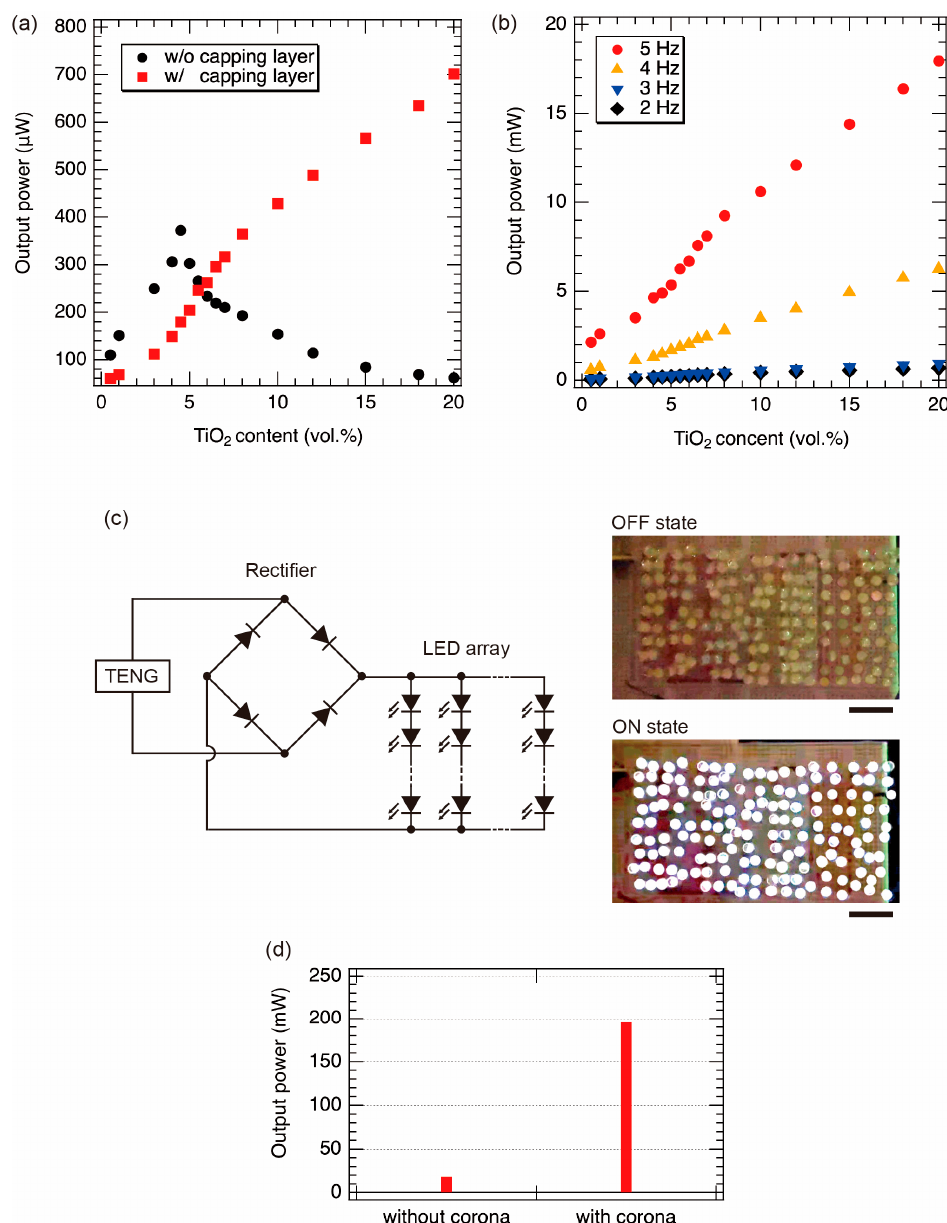
Figure 7. ( a ) The relationship between the content of TiO 2 NPs and the output power. ( b ) The output power at the frequencies of 2, 3, 4, and 5 Hz. ( c ) The schematic circuit of TENG connections with an LED array. Photographs of LED array for OFF and ON states. Scale bars are 2 cm. ( d ) The comparison between the output power with and without corona discharge.